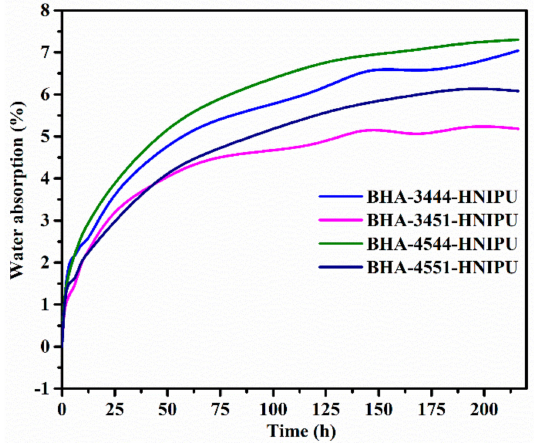
Figure 15. Water absorption of